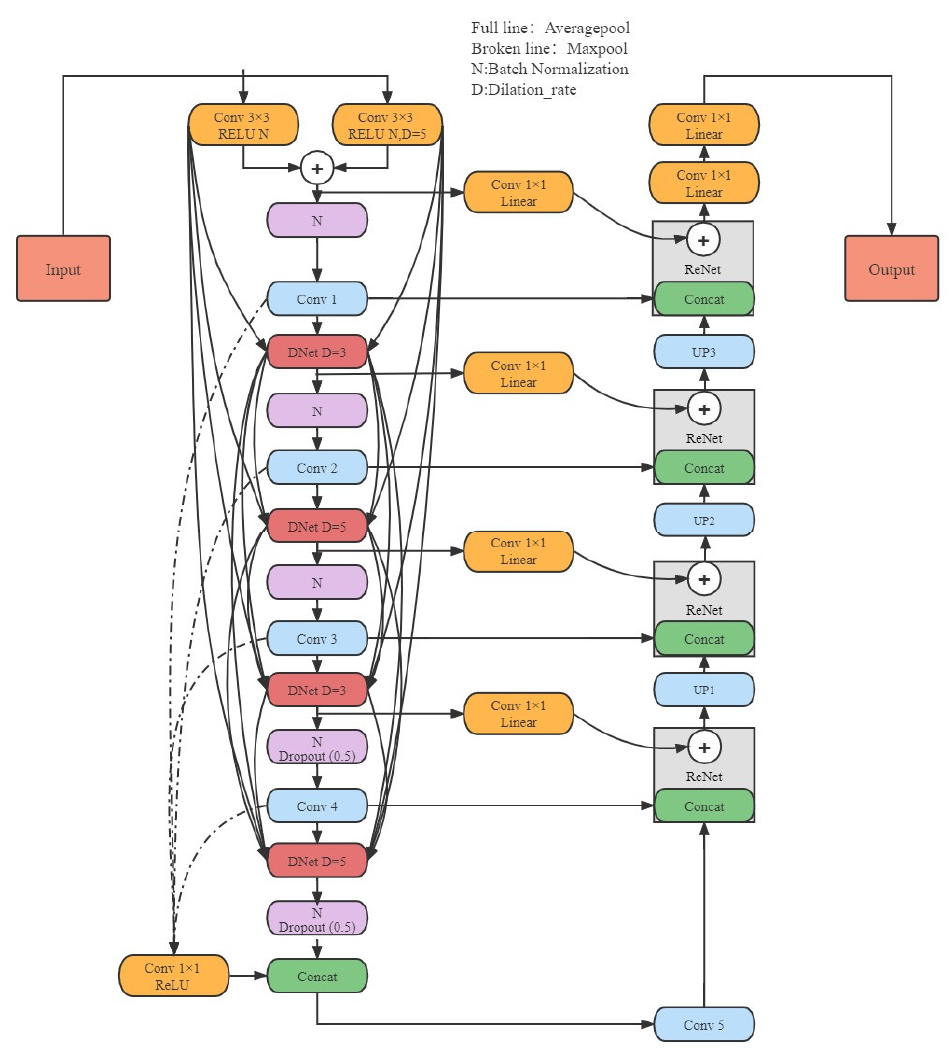
Figure 6. Schematic presentation of the MDRU-Net structure.